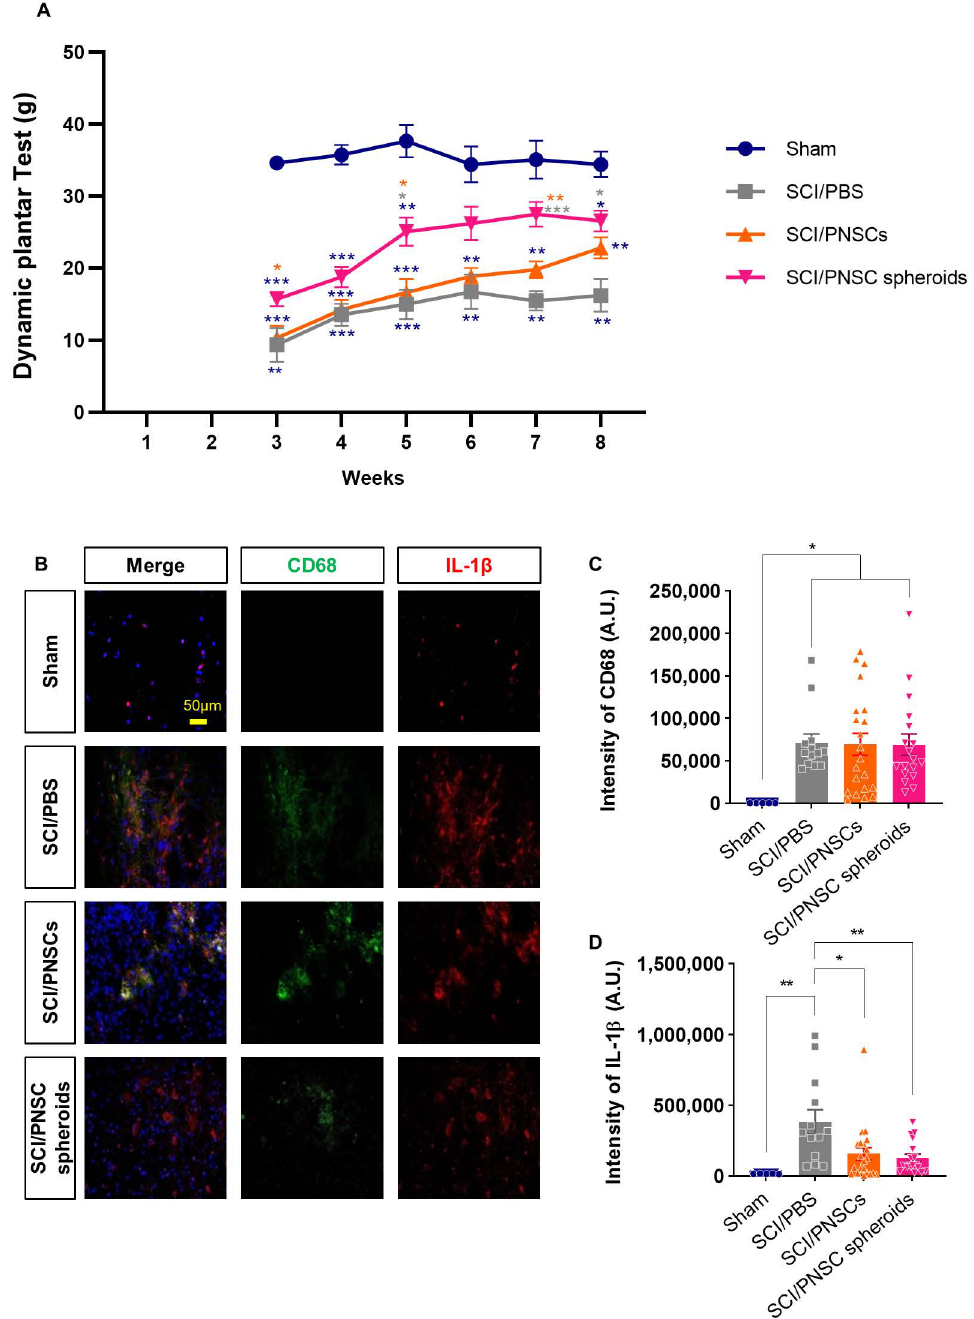
Figure 5. Peripheral nerve-derived stem cell (PNSC)-mediated improvement in mechanical allodynia and inflammation. ( A ) Mechanical allodynia assessment using a dynamic plantar test. Testing began three weeks after SCI and continued until eight weeks after SCI. Data were analyzed by using a two-way ANOVA with Holm–Š í d á k’s multiple comparisons. ( B ) Representative imaging showing DAPI (blue), anti-CD68 (green), and anti-IL-1 β (red) staining eight weeks after SCI. ( C ) Total CD68 staining intensity in all groups (Sham, n = 5; SCI/PBS, n = 13; SCI/PNSCs, n = 21; and SCI/PNSC spheroids, n = 28). Ordinary one-way ANOVA with Tukey’s multiple comparisons was used for analysis. ( D ) Total IL-1 β staining intensity in all groups (Sham, n = 5; SCI/PBS, n = 13; SCI/PNSCs, n = 21; and SCI/PNSC spheroids, n = 28). Ordinary one-way ANOVA with Tukey’s multiple comparisons was used for analysis. All data are expressed as mean ± S.E.M.; * p < 0.05, ** p < 0.01, and *** p <